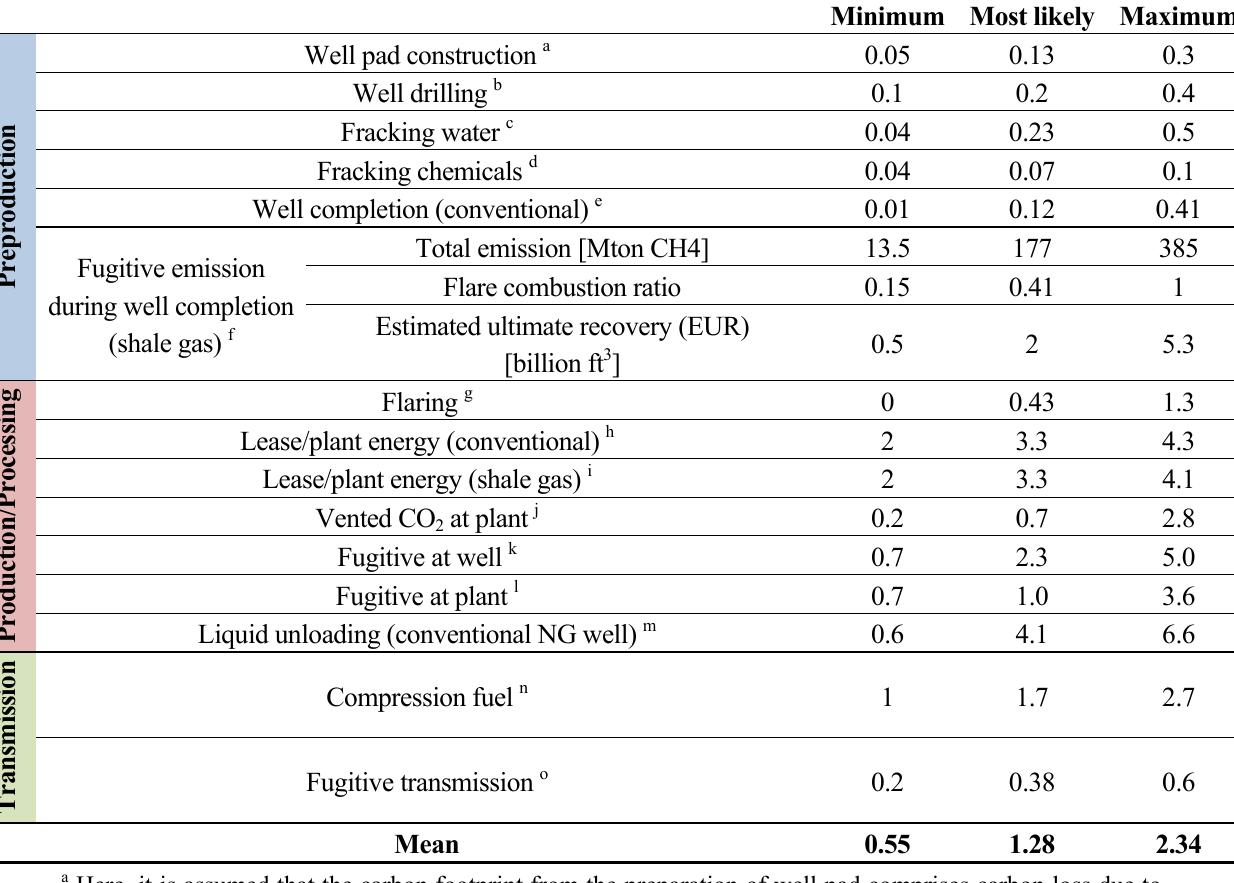
Table 1. Input parameters to Monte Carlo simulation for each category of emission in shale gas and conventional NG development using six published studies (Weber and Clavin [8]). Units: gCO e/MJ (grams of carbon dioxide equivalent per mega joule) unless 2 otherwise